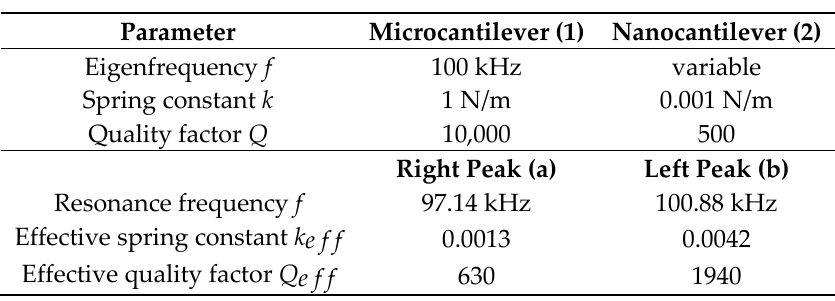
Figure 1. ( a ) Coupled harmonic oscillator model for a co-resonantly coupled cantilever system. Each subsystem 1, 2 is represented by a spring k 1,2 , a damping element d 1,2 and effective mass m 1,2 . The driving force is applied to subsystem 1 and an external interaction applied at the nanocantilever can be modelled by an additional spring k 3 which represents a force gradient. ( b ) Amplitude response curve of the coupled system calculated for the microcantilever (amplitude normalized to the greatest value within the curve) and the parameters given in Table 1 for − 2% eigenfrequency deviation, i.e., f 2 = 98 kHz. The relevant definitions are indicated. Table 1. Exemplary sensor parameters based on experimental sensors for the individual micro- (1) and nanocantilever (2) before eigenfrequency matching (upper part). The lower part of the table summarizes the effective properties for both resonance peaks a and b for − 2% eigenfrequency matching of micro- and